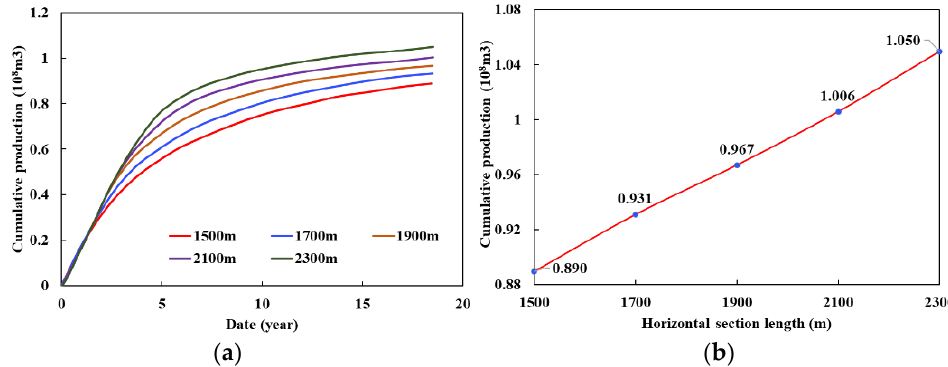
Figure 13. The change in cumulative production under different conditions: ( a ) different horizontal